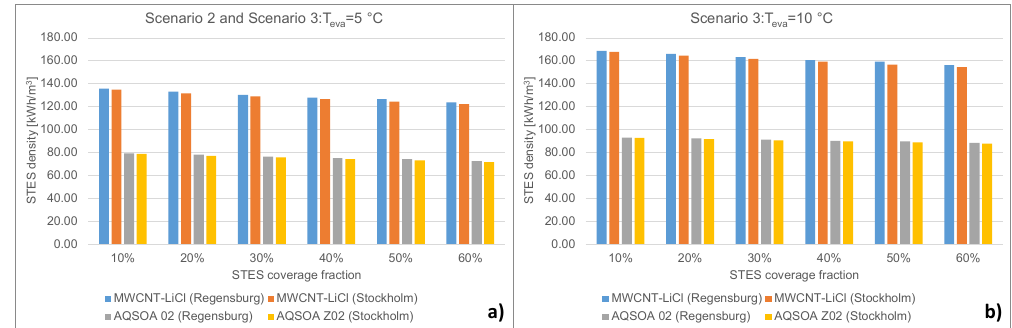
Figure 10. STES energy density calculated for Scenario 2 corresponding also to Scenario 3 with evaporation temperature set at 5 °C ( a ) and Scenario 3 with evaporation temperature set at 10 °C ( b ), for the identified working pairs (i.e., MWCNT-LiCl/water and AQSOA 02/water), both in Regensburg and Stockholm.